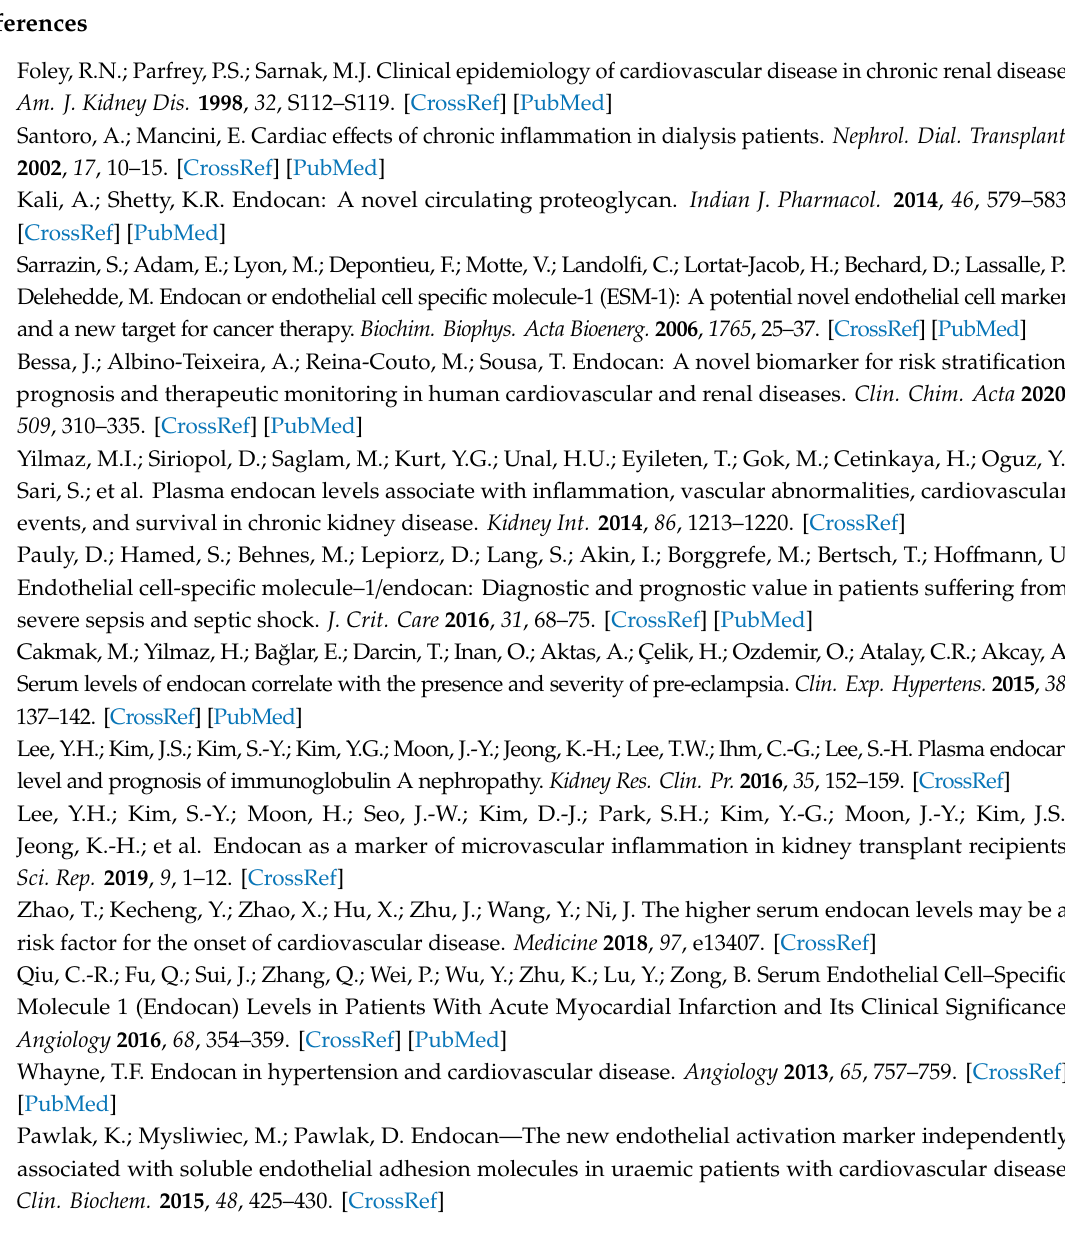
Table S1: Non-cardiac death according to plasma endocan